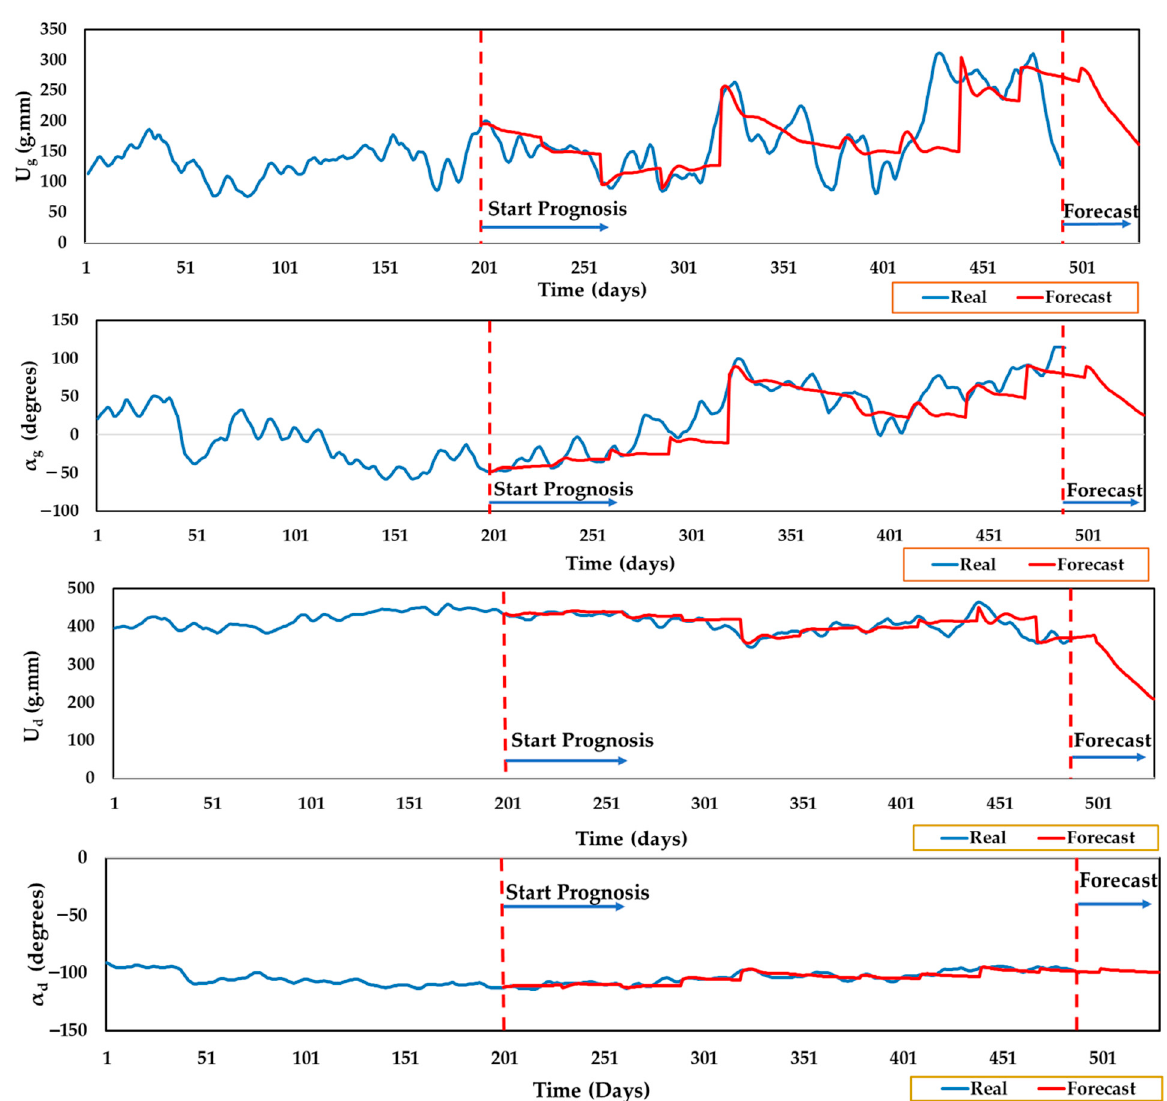
Figure 17. Prognostic curves for unbalance in a rotor-bearing system.